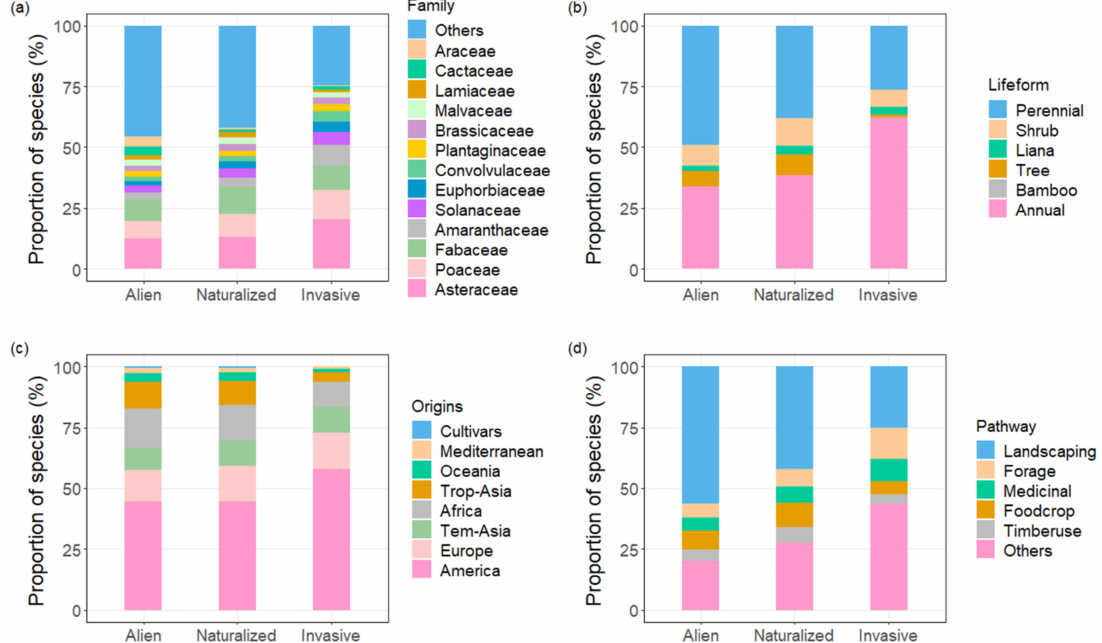
Figure 1. Proportions of plant species comprising alien, naturalized and invasive plants, by family ( a ), lifeform ( b ), origin ( c ) and introduction pathway ( d ). See more details for the abbreviations and categories in Table